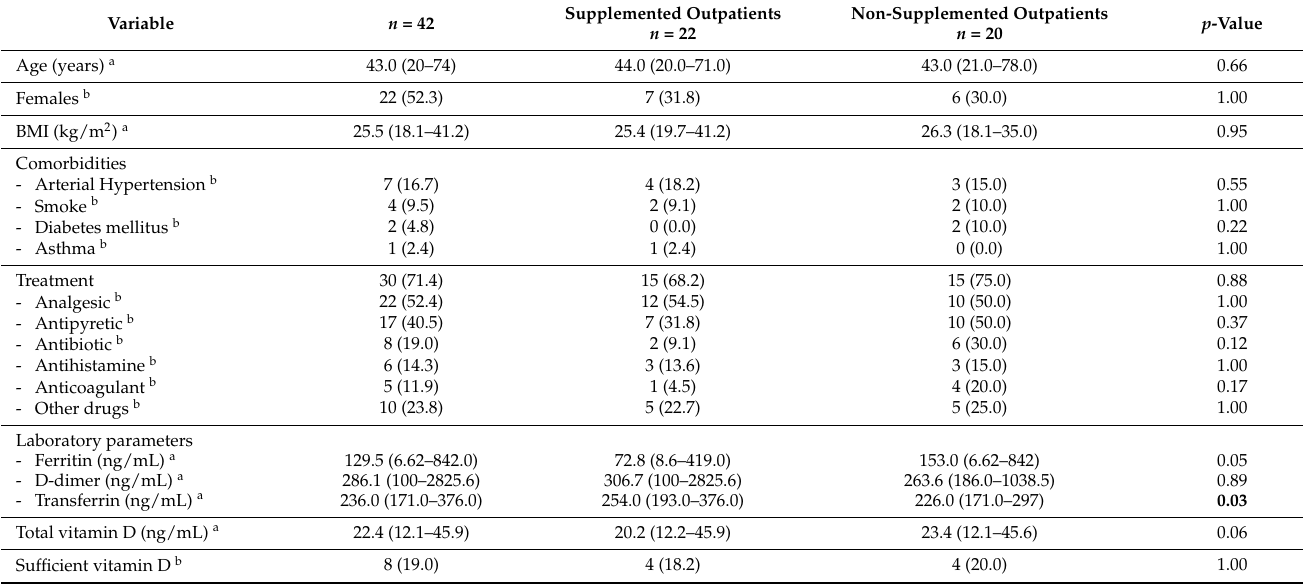
Table 1. Demographic and treatment features of positive COVID-19 outpatients at